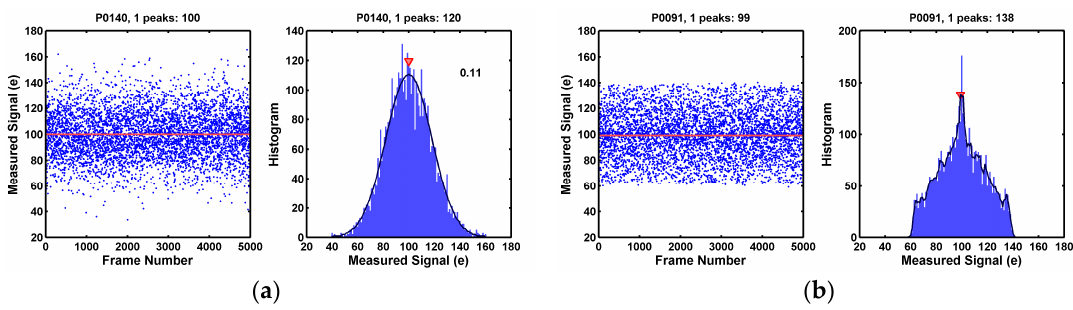
Figure 24. ( a , b ) Two examples pixels showing one peak with relatively high RMS noises. It is not clear whether these pixels have no RTN traps, one trap, or many traps. We speculate that at least some of these pixels have one or many RTN traps with closely spaced discrete levels, or with very short time constants, such that the readout circuit cannot separate the peaks.